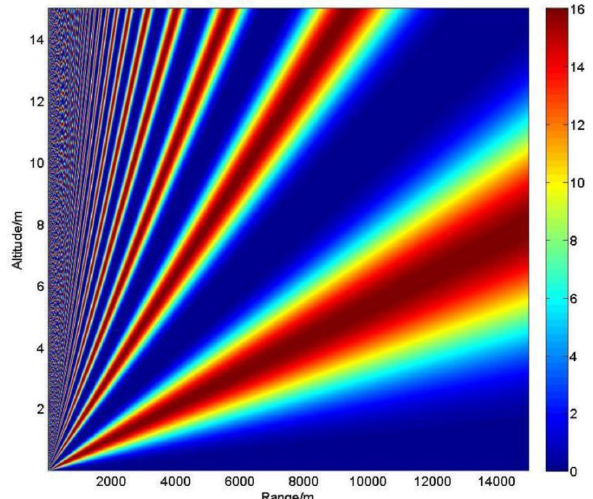
Fig. 8 The radiation field power gain